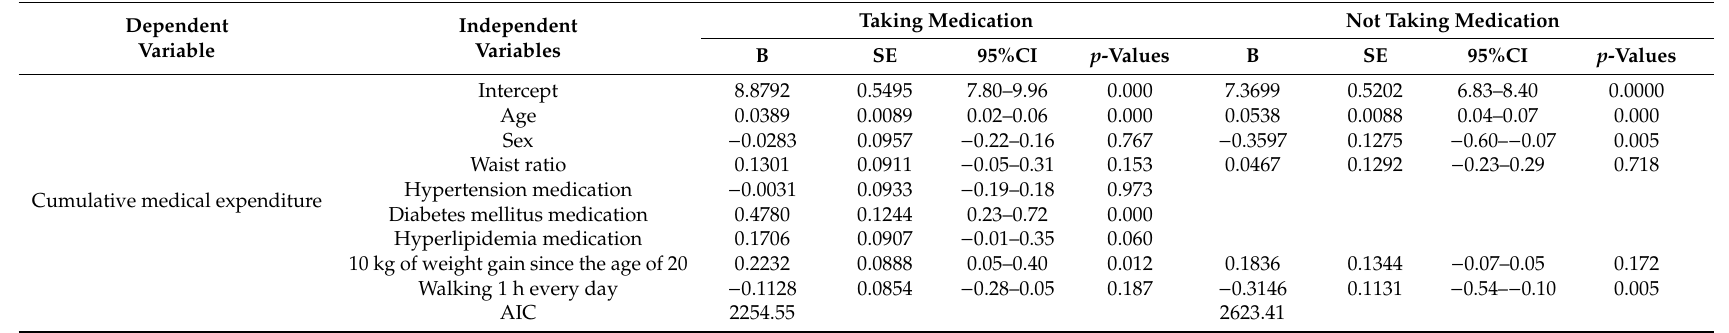
Table 3. Results of the Tobit regression analyses with individual 5-year cumulative outpatient and medication expenditure as the dependent variable sorted into medication status